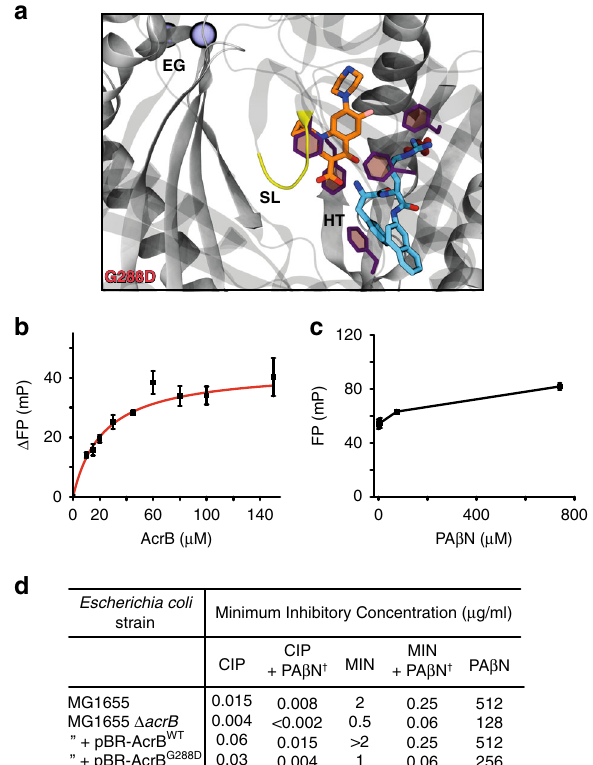
Fig. 5 AcrB G288D is inhibited by the EPI PA β N. a Molecular docking and multi-copy μ s-long MD simulations reveal stable interactions of CIP (orange) and PA β N (cyan) to AcrB G288D T-state monomer and show their likely binding locations. The pose and its orientation are the same as shown for AcrB WT in Fig. 3c. EG = exit channel gate (blue spheres), SL = switch- loop (yellow), and HT = hydrophobic trap (purple). All computational data, including binding free energies can be found in Supplementary Table 5 and Supplementary Figs. 8, 14 – 16. b Binding of CIP by AcrB G288D in the presence of 150 μ M of PA β N as determined by a fl uorescence polarization assay performed by Su et al. 39 . All data are fi t as in Fig. 3a ( R 2 = 0.99). Data are the average and standard deviation from independent measurements ( n = 3). c Binding competition assay between PA β N and CIP for AcrB WT . Data are the average and standard deviation from independent measurements ( n = 3). d MIC assays of Escherichia coli containing AcrB WT or AcrB G288D in the presence of PA β N and antibiotics. AcrB was overexpressed in MG1655 Δ acrB from a pBR322 plasmid containing its corresponding acrAB genes, natural promoter and “ marbox ”